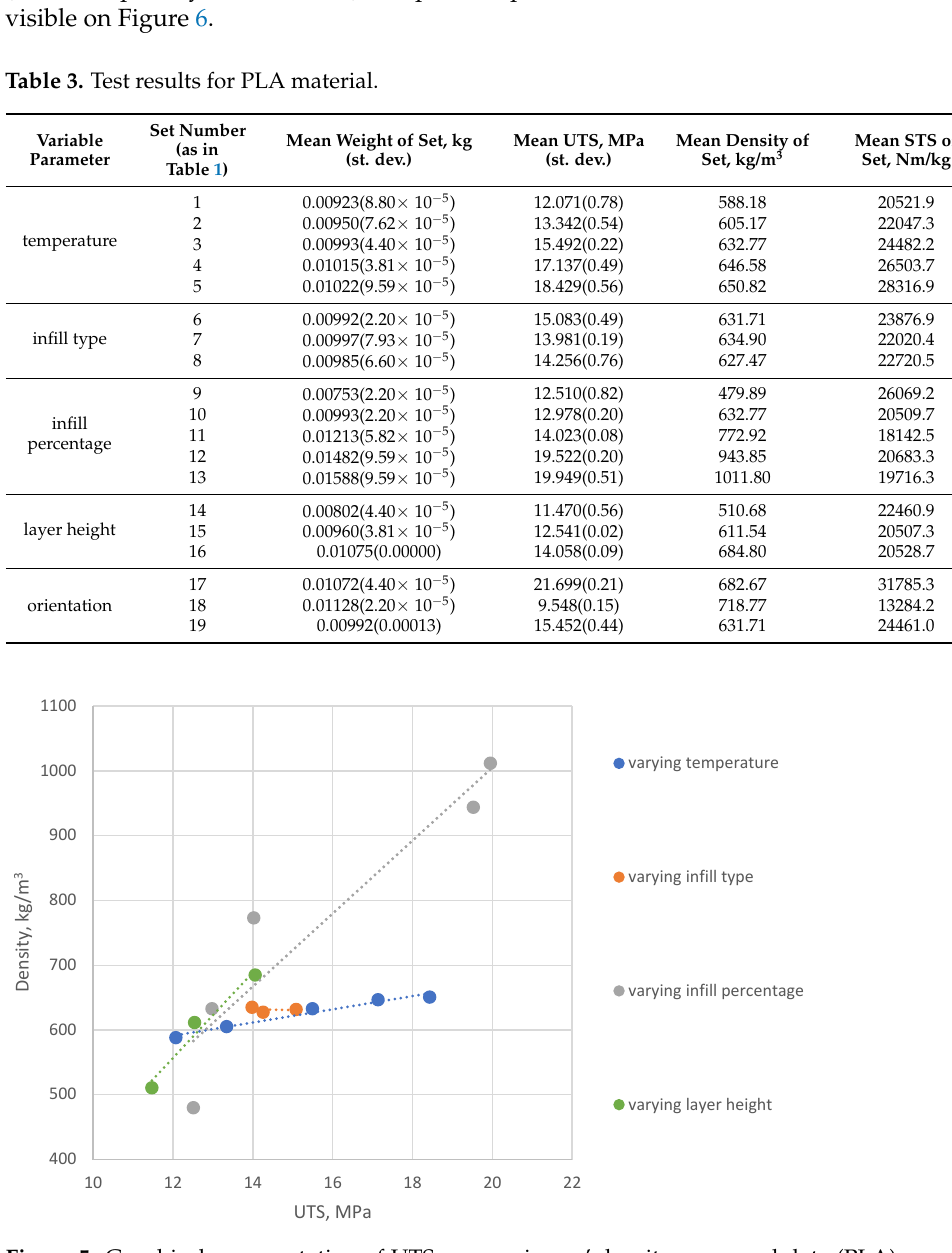
( b ) Figure 6. UTS/STS vs. infill percentage graphs for PET-G( a ) and PLA( b ). Simplifying the data interpretation by assuming linear change as the infill percent- age increases, it is possible to extrapolate optimal strength-to-weight ratio in both mate- rials’ cases using obtained linear approximation formulas presented there. It is visible that for both materials, the optimal value is close to 50% infill.